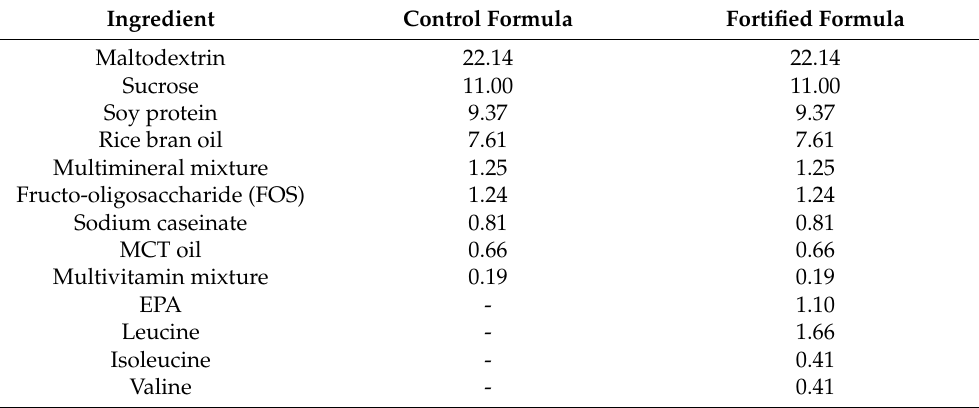
Table 1. Ingredients of the control and fortified formulas (250 g/serving). Ingredient Control Formula Fortified Formula Maltodextrin 22.14 Sucrose Soy